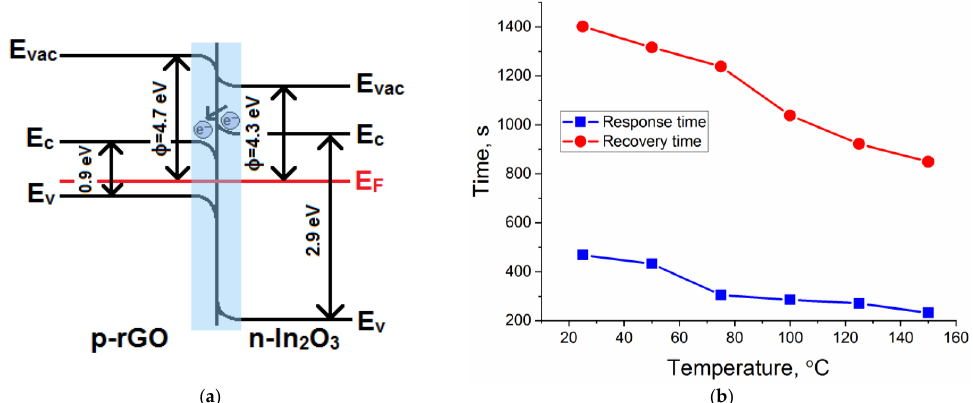
Figure 7. A schematic illustration of the p – n heterojunction formation in the rGO – In 2 O 3 interface ( a ); response and recovery times of the In 2 O 3 /rGO (1%) composite under UV illumination at different operating temperatures ( b ).